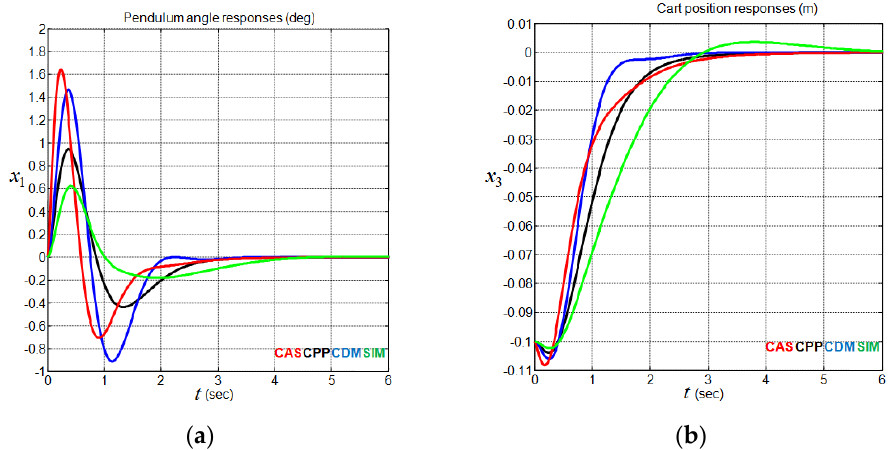
Figure 12. CIP output responses using CAS, CPP, CDM, and SIM methods. ( a ) Pendulum angle responses; ( b ) cart position responses. Table 5. Controller performance comparison using nonlinear CIP